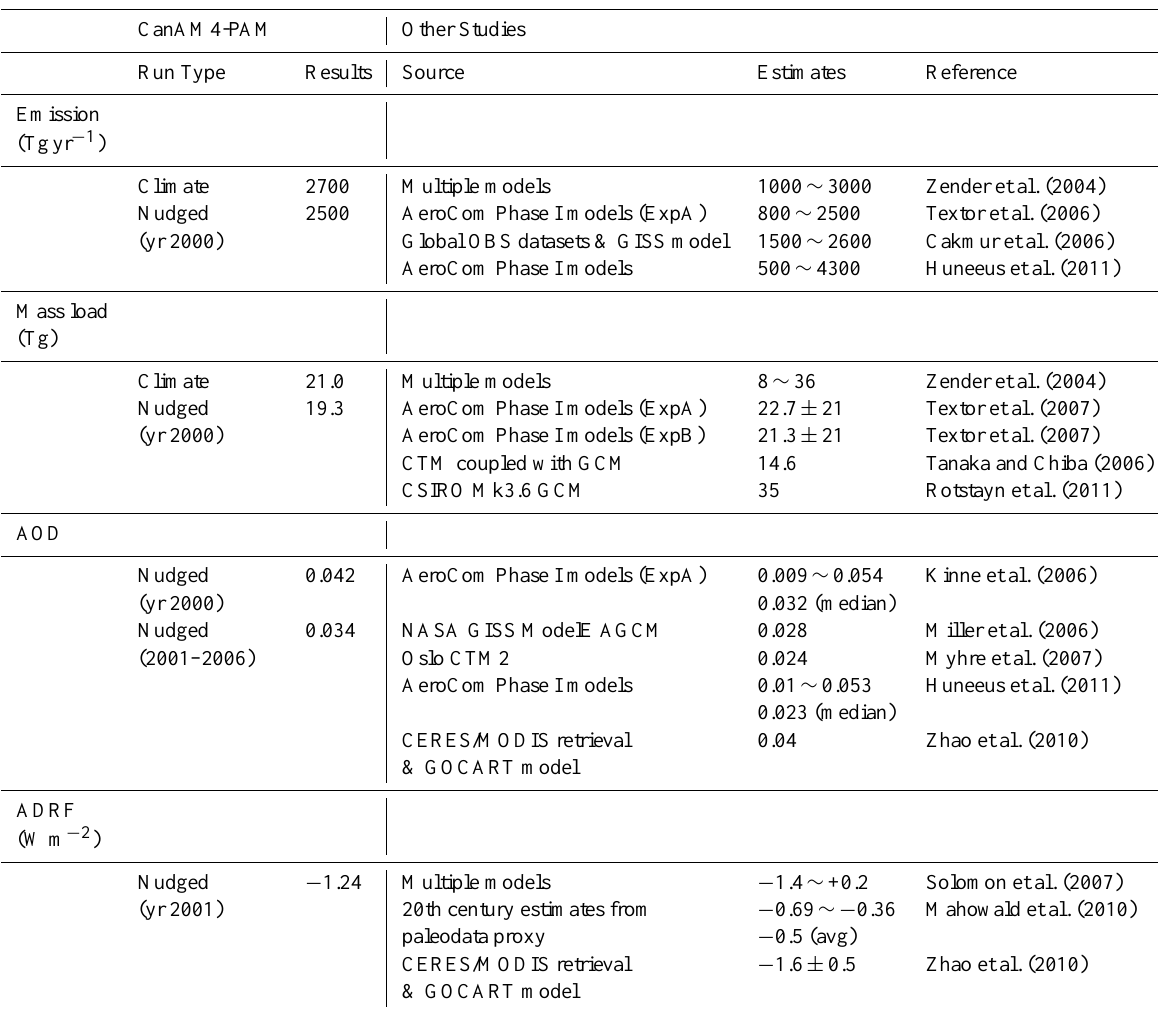
Table 3. Summary of annual global dust emission, mass load, AOD at 0.55µm and shortwave ADRF at TOA from CanAM4-PAM and from other recent